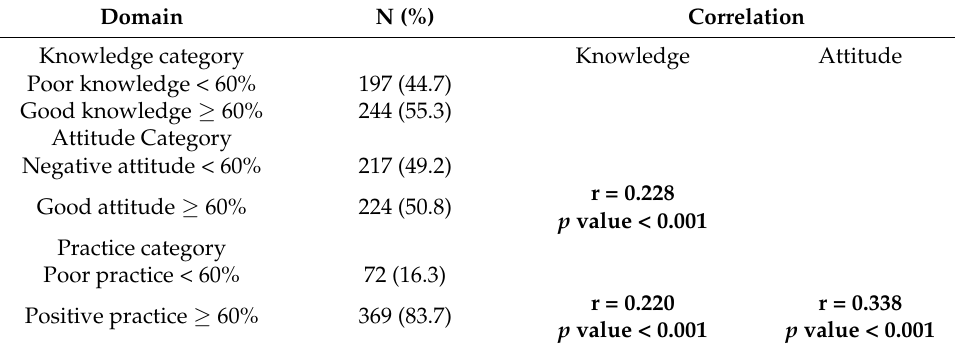
Table 5. Correlation between knowledge, attitude, and practice of COVID-19 of study participants of Phuentsholing Hospital,